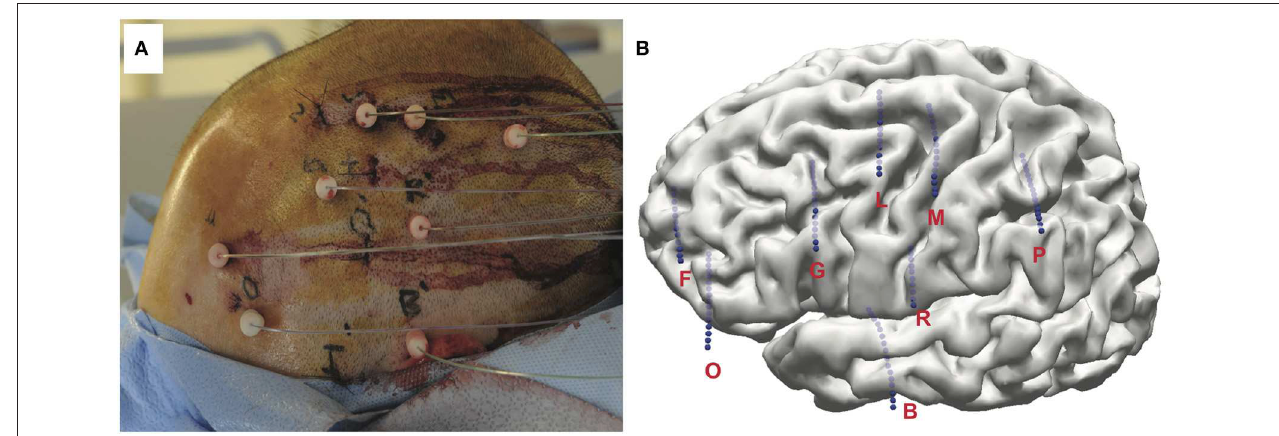
FIGURE 1 | (A) Example of a final postoperative image of left frontal-temporal-parietal SEEG implantation. Subject shown did not perform task. (B) Three-dimensional MRI reconstruction showing details of subject’s unique cortical anatomy and the relative position and depth of of implanted electrodes.